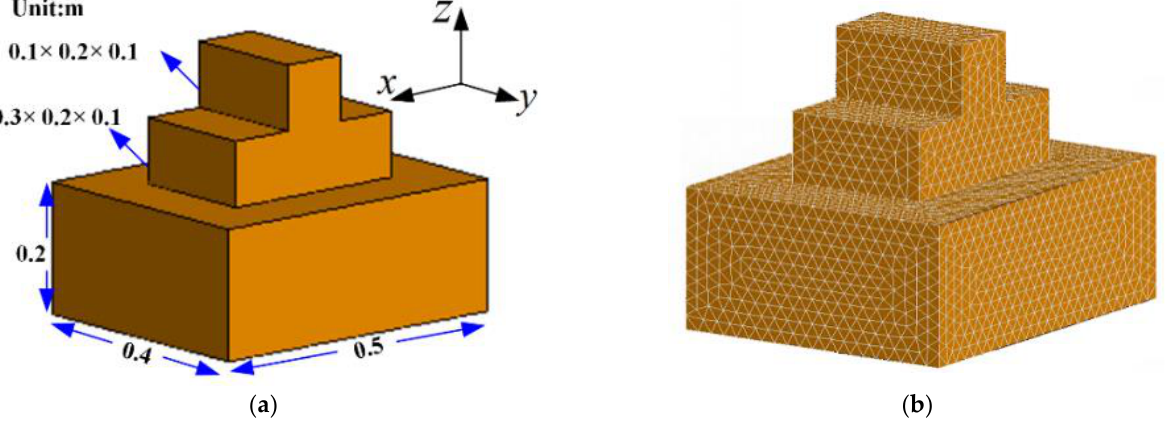
Figure 6. Combined cuboid model ( a ) Geometry; ( b ) Subdivision model.